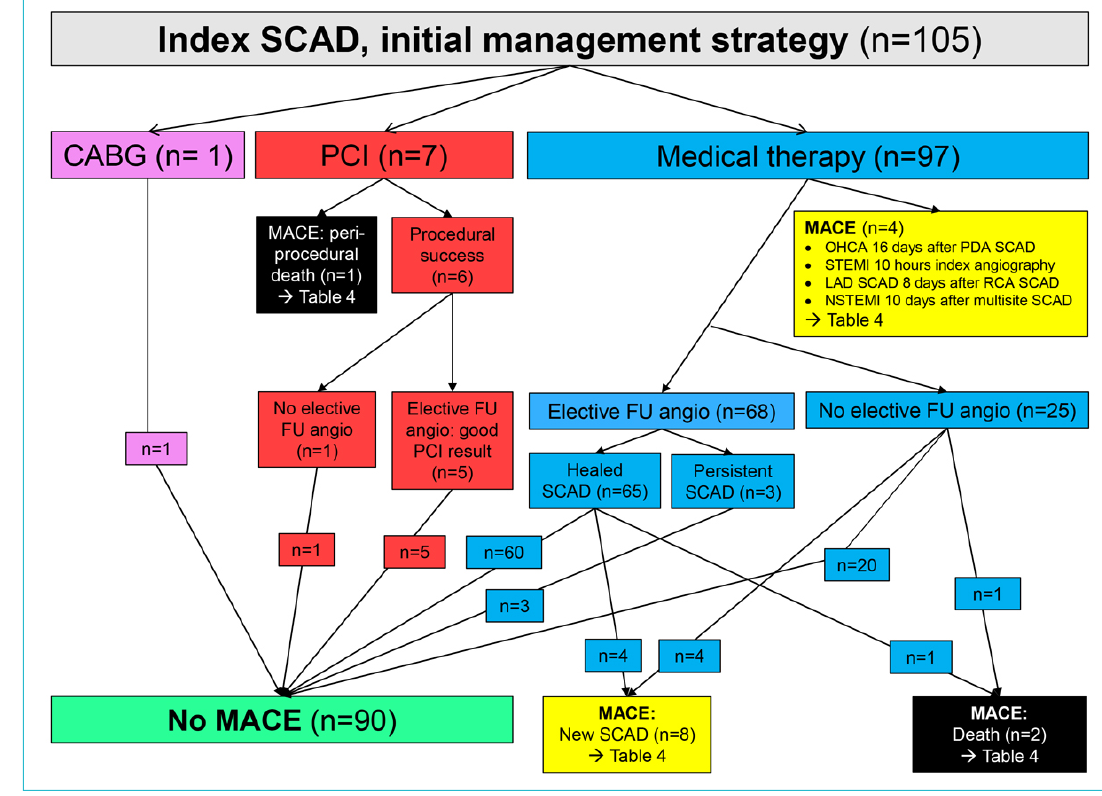
Figure 1: Patient flow for the entire cohort of patients with spontaneous coronary artery dissection (SCAD). For details see text and table 4. CABG: coronary artery bypass grafting; FU: follow-up; LAD: left anterior descending artery; MACE: major cardiovascular events; OHCA: out- of-hospital cardiac arrest; PCI: percutaneous coronary intervention; PDA: posterior descending artery; RCA: right coronary artery; STEMI: ST- segment elevation myocardial